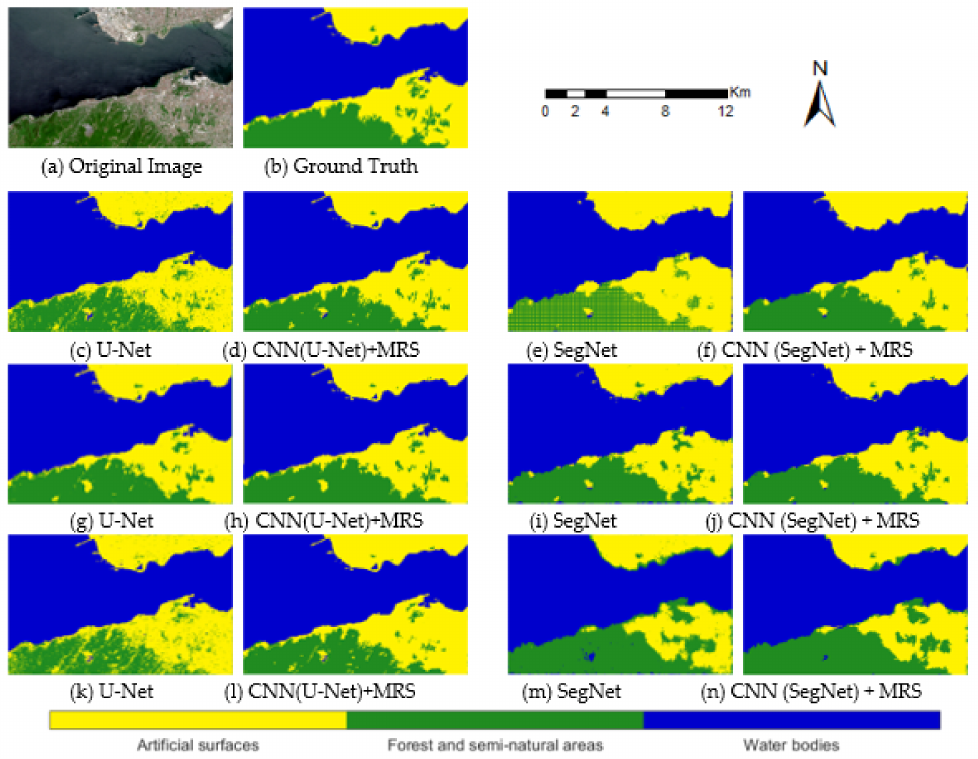
Figure 14. Kocaeli test area results of CNN models and CNN–MRS models with five-band dataset ( c – f ): 32 × 32 patch size; ( g – j ): 64 × 64 patch size; ( k – n ): 128 × 128 patch size.